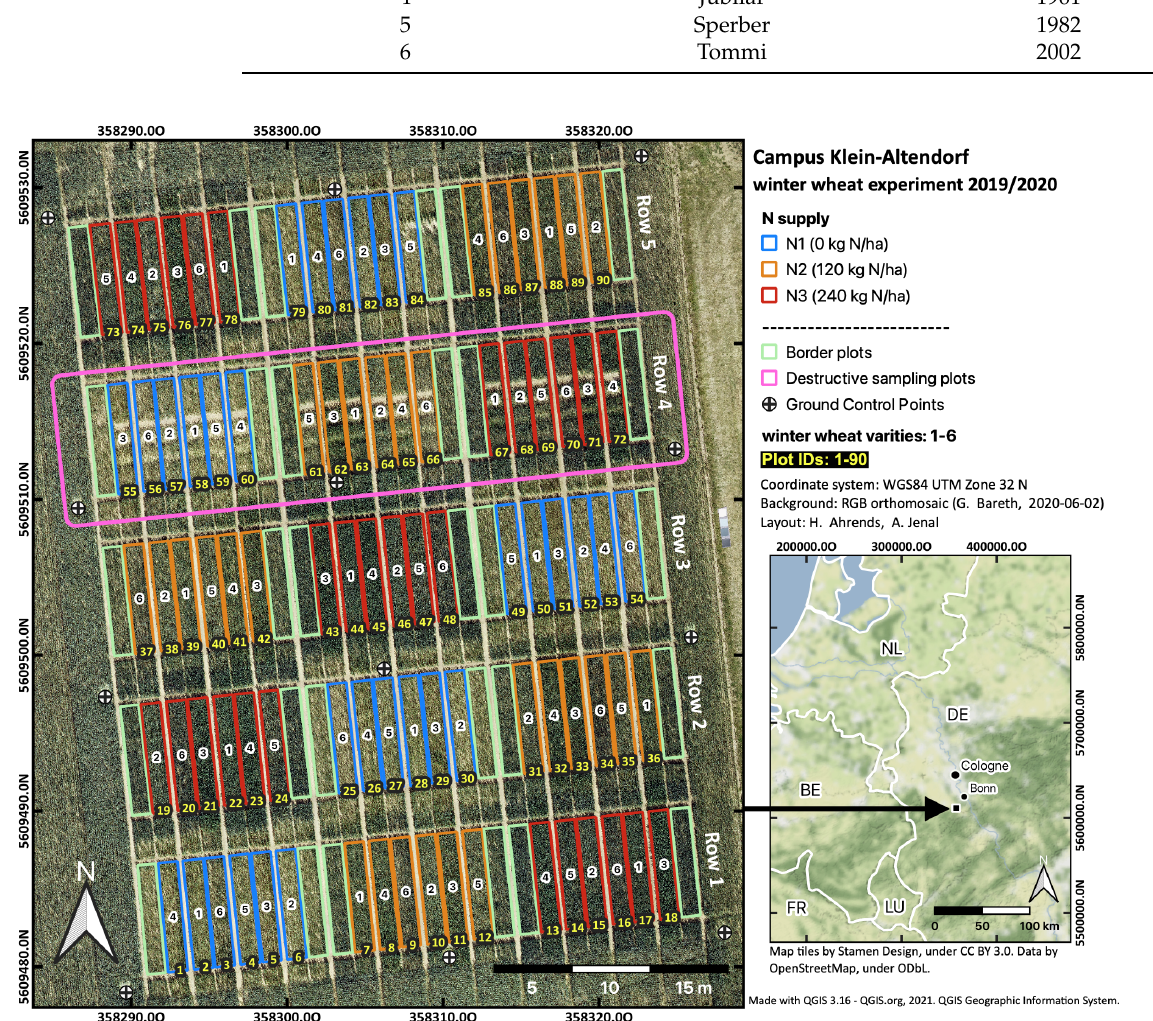
Figure 2. Location map and additional information of the winter wheat experiment at Campus Klein-Altendorf